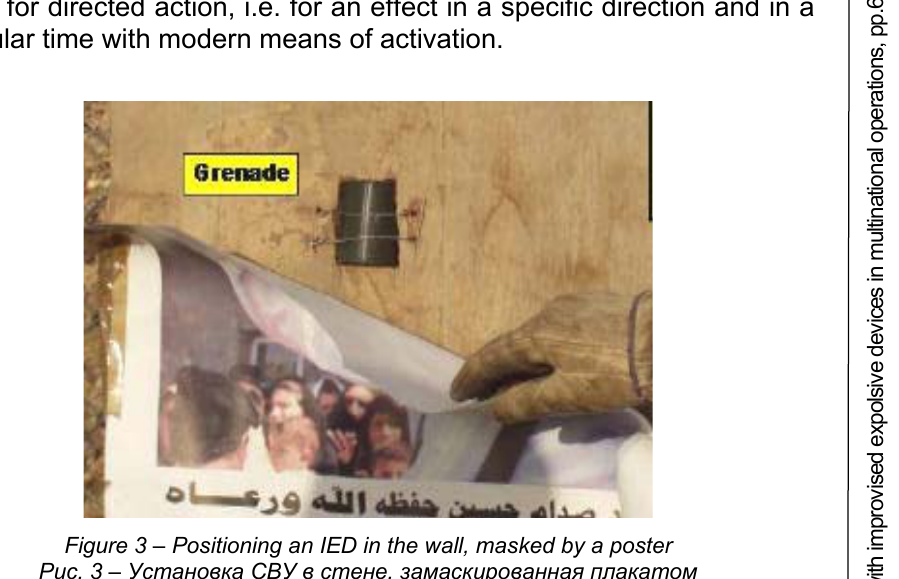
Рис . 3 – Установка СВУ в стене , замаскированная плакатом